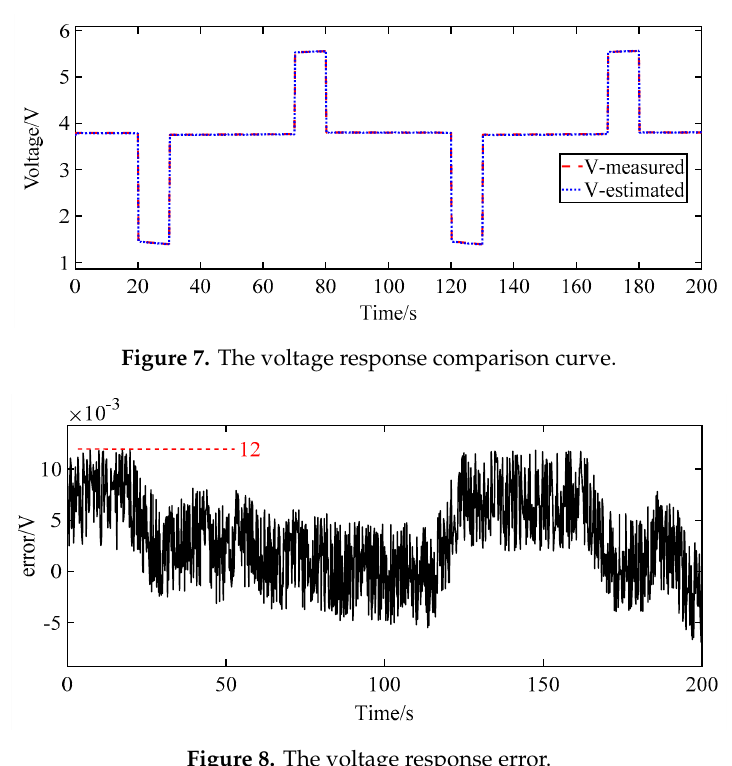
Figure 8. The voltage response error.